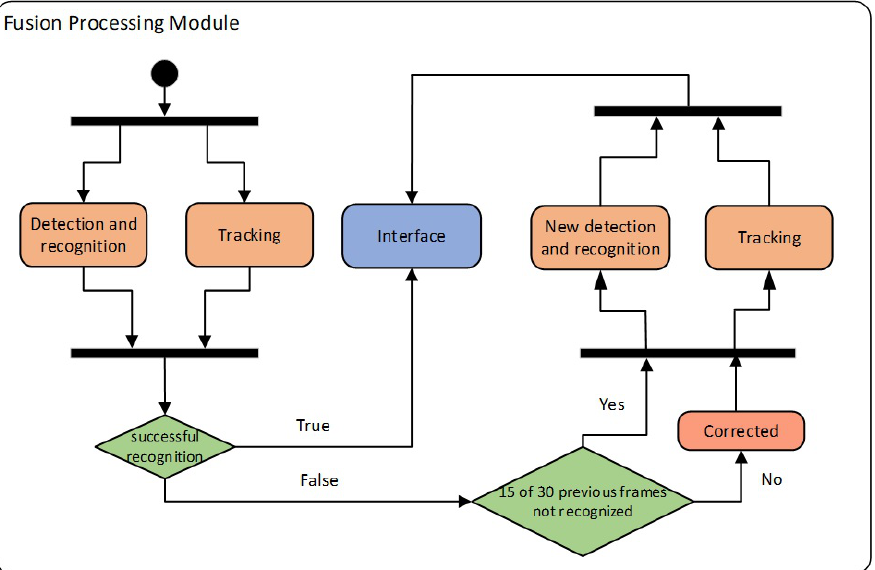
Figure 4. The fusion processing module. We fused the detection and recognition results on multiple- object-tracking